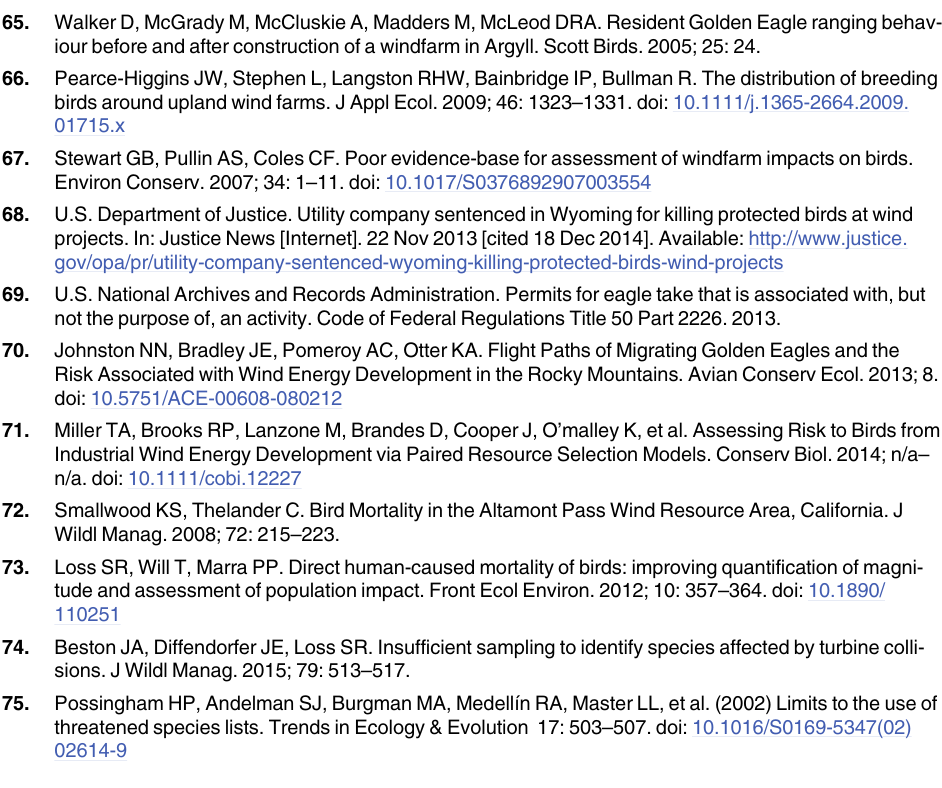
PLOS ONE | DOI:10.1371/journal.pone.0150813 March 10,